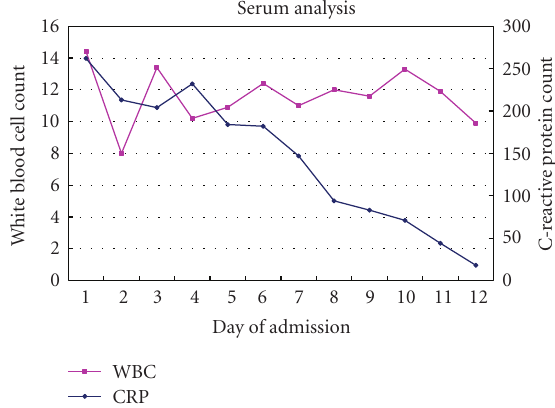
Figure 3: Serum analysis of white cell count and C-reactive protein levels during admission. Antibiotic (ABx) switch at day 10 from Benzylpenicillin and Flucloxacillin to Teicoplanin and Fusidic Acid for presumed